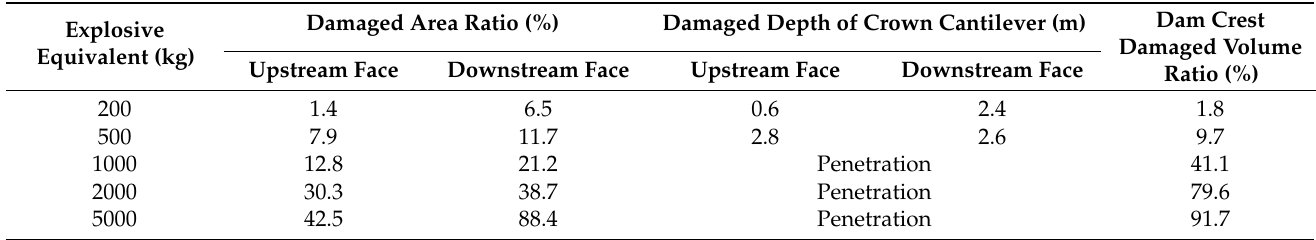
Table 1. Failure of the arch dam under various explosive